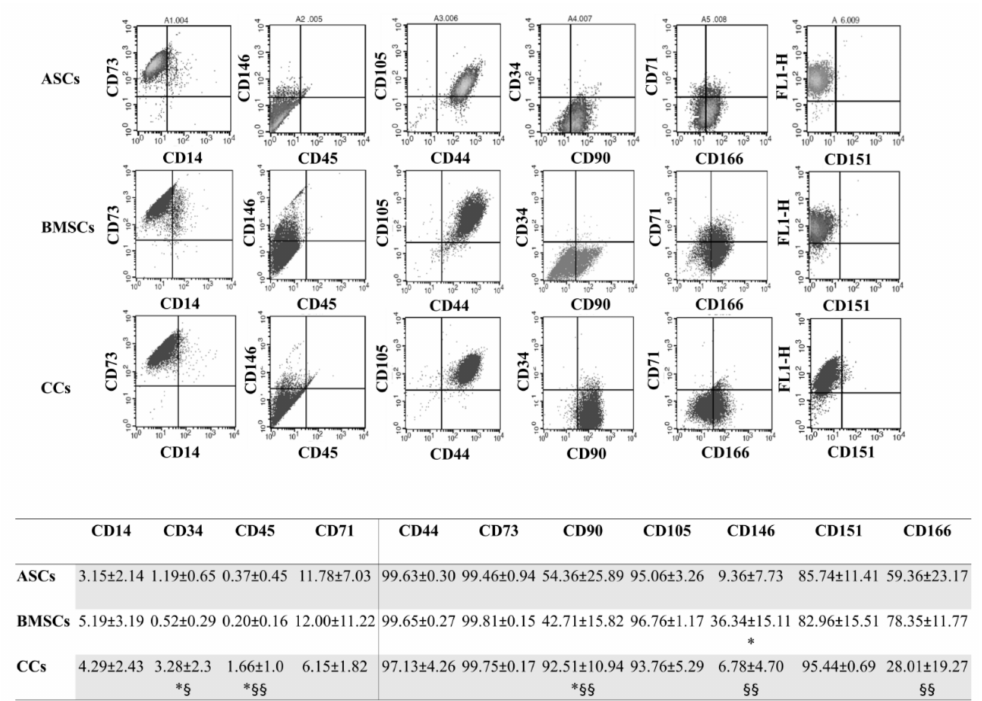
Figure 3. Immunophenotype. Representative expression of the typical pattern of MSC surface markers in all the analyzed cells, with a table reporting the percentages of positive cells for the whole panel of surface markers tested at P4. Adipose (ASCs)-, bone marrow (BMSCs)-derived MSCs, and cartilage cells (CCs). * p < 0.05 vs. ASCs, § p < 0.05, §§ p < 0.05 vs. BMSCs. Data are expressed as mean ± SD ( n =